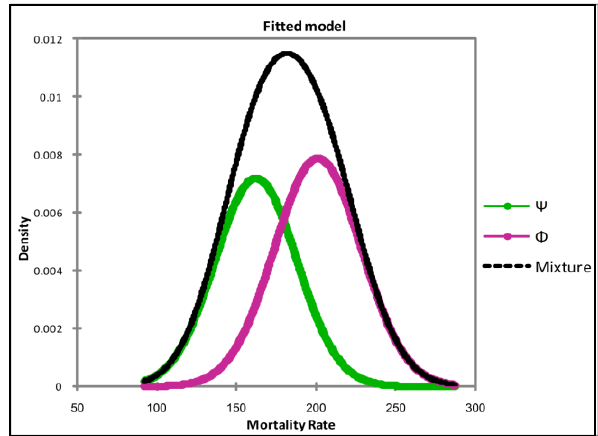
Table 2 : Non-parametric correlation of the mortality rates from malignant diseases versus time (in years) at CI 95% with two-tailed P-value using Prism - GraphPad v6.01